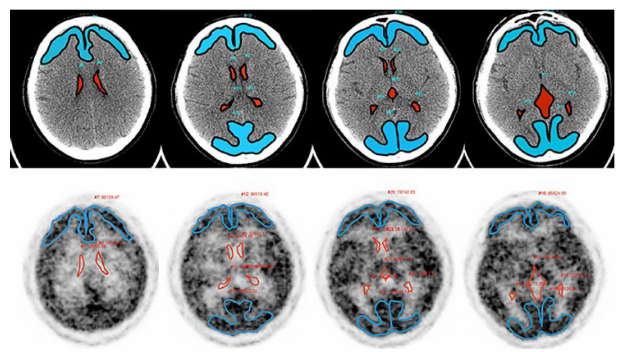
Figure 2. The ROIs for analyzing the interstitial water flow were defined utilizing CT ( upper ) and [ 15 O]H 2 O PET ( lower ) images on a Xeleris 3.1 workstation. [ 15 O]H 2 O PET images in 60–120 s after the administration were reconstructed to confirm the cortex, which had high uptake regions. Blue areas: frontal and occipital cortex. Red areas: lateral and third